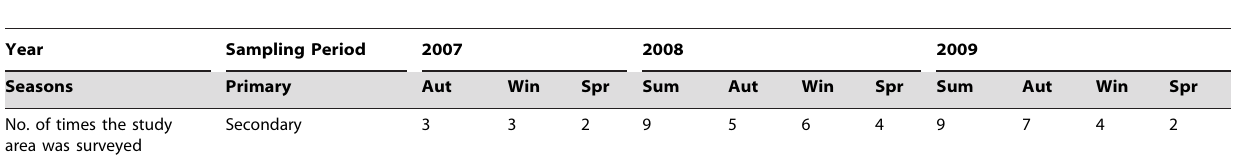
Figure 1. A map of the 120km2 study area in the near-shore environment around Bunbury, Western Australia. The extent of the three zones of transect lines (dashed zigzag line). Both Zone 1 (Buffalo Beach) and Zone 2 (Peppermint Beach) were coastal waterways, while Zone 3 (Bunbury Inner) consisted of inner waters including the Leschenault Inlet and Estuary, Inner and Outer Harbour, Koombana Bay and the lower reaches of the Collie River. doi:10.1371/journal.pone.0076574.g001 survey , with each dolphin group encounter during a survey termed used during boat-based surveys as a capture-recapture method for estimating abundance, demographic parameters and movements a sighting . Using a Nikon D 200 with Nikkor zoom lens 70– of bottlenose dolphins. One field day of effort was defined as a 300 mm, photographs were taken of individual dolphins encoun- Table 1. Sample sizes of the two-tiered data structure consisting of primary (seasons) and secondary sampling periods (no. of times all three zones of the study area were surveyed) of the Robust